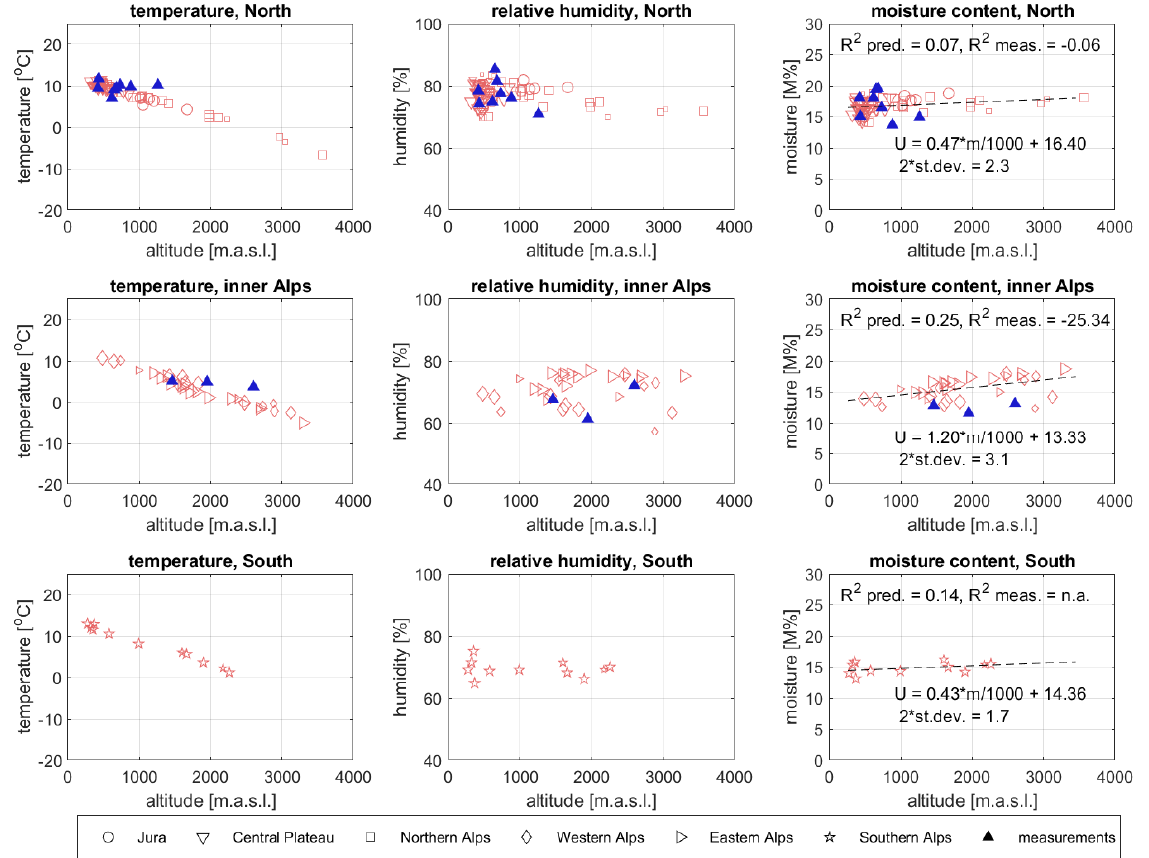
Figure 11. Comparison of annual average temperatures, relative humidity, and moisture contents for the structures located in the three different regions (bottom). Parameter m represents altitude.